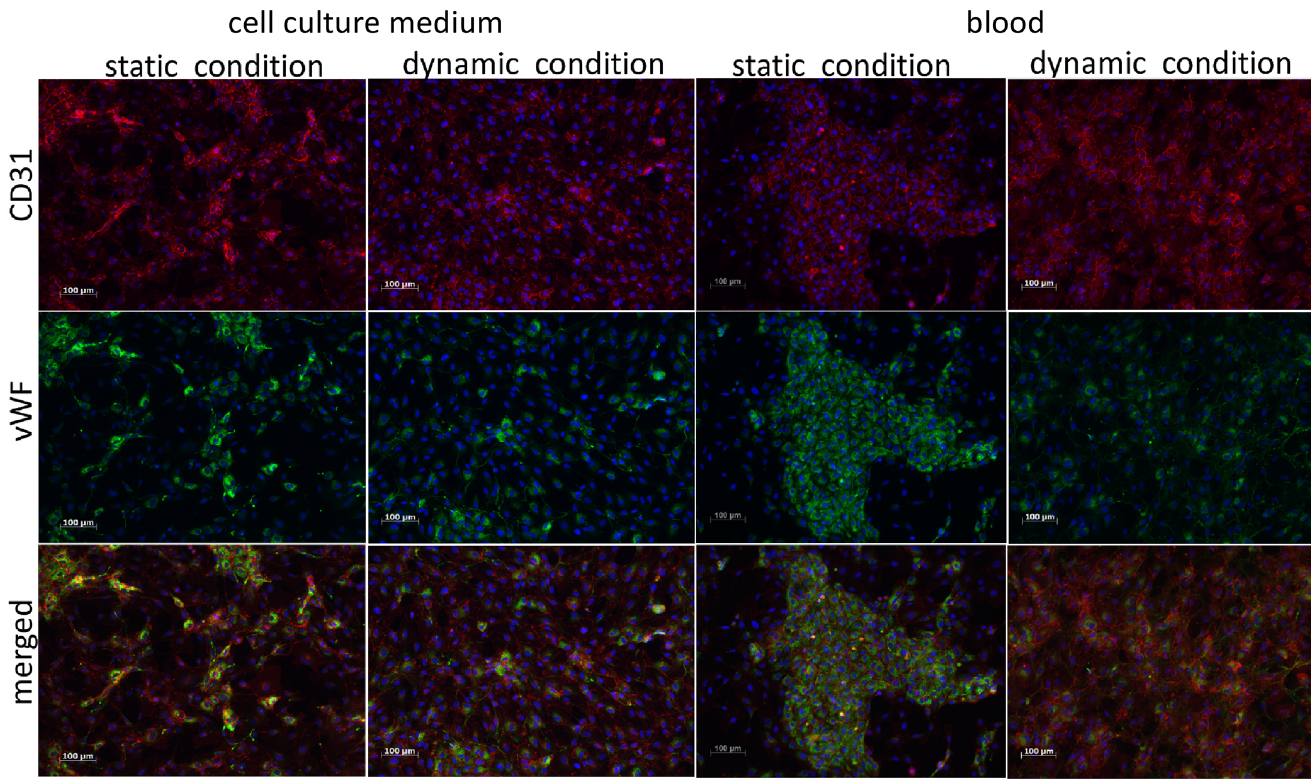
Fig 5. Fluorescence staining against CD31 and vWF for dynamically and statically cultured endothelial cells incubated with either cell culture medium or blood. Static incubation incubation with blood was done for 90 minutes whereas blood was perfused for 180 minutes. All samples stain positive for CD31 and vWF, proving endothelial lineage. Blood incubation does not alter marker expression. Scale bar = 100 μ m.